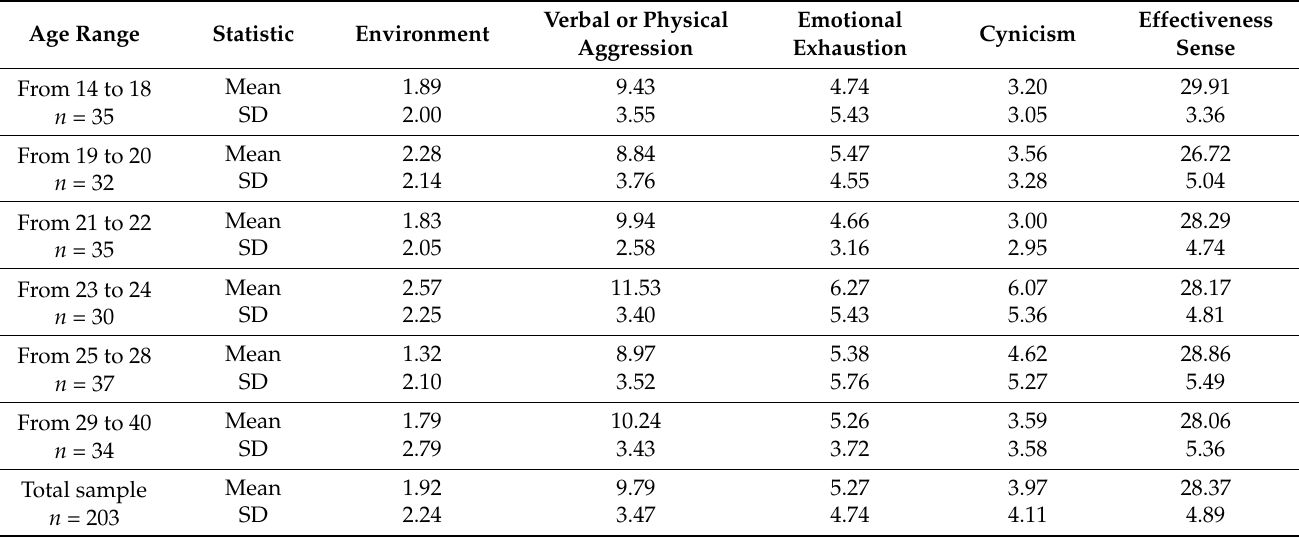
Table 4. Descriptive statistics of each factor depending on their age.